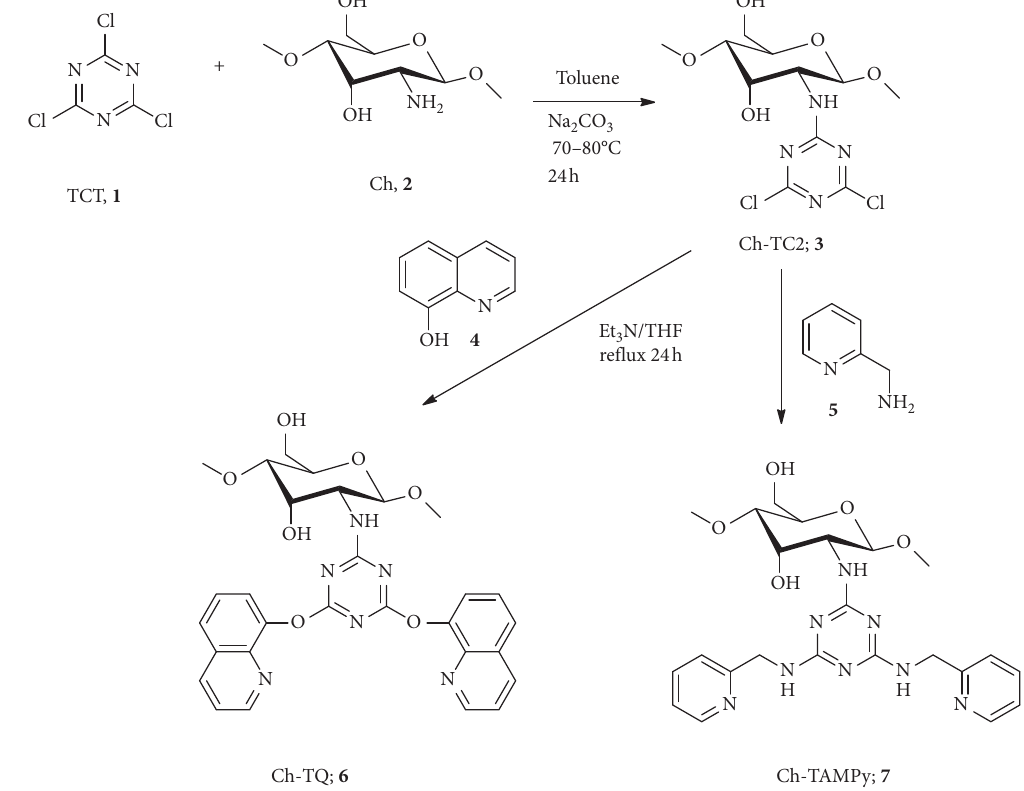
Scheme 1: Synthesis of modified chitosan Ch-TQ 6 and Ch-TAMPy 7 .